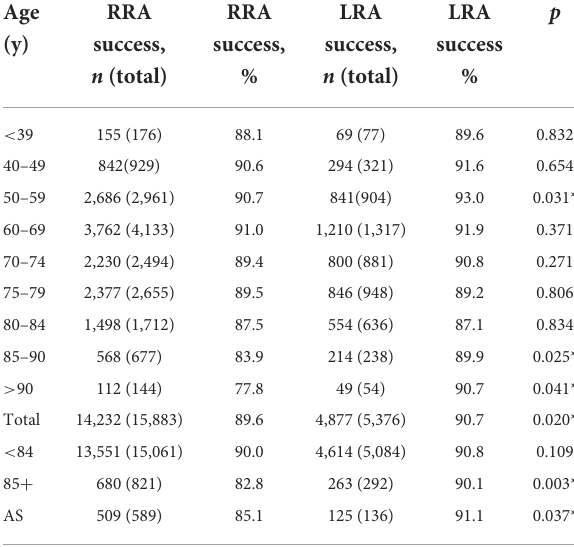
TABLE 1 Predictors of transradial success in a logistic regression model. Independent variable